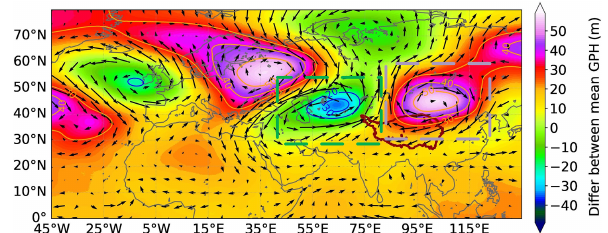
Figure 16. Differences (Differ) in summer (July) geopotential height (GPH) at 200hPa between the warm (1995–2014) and cold (1961–1994) phases of the AMO (the later stage minus the former stage). The bold red line represents the border of the